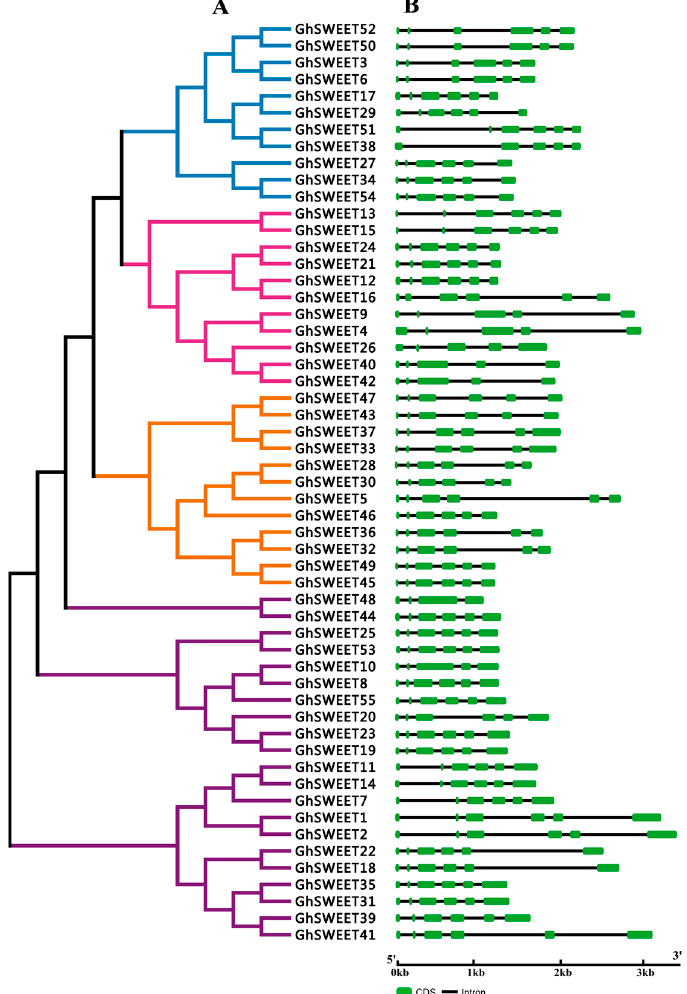
Figure 2. Phylogenetic relationships and structural features of GhSWEET genes. ( A ) Neighbor-joining phylogenetic tree of GhSWEET genes. The SWEET genes were classified into four clades, and blue, pink, purple, and orange represent Clades I, II, III, and IV, respectively. ( B ) Exon-intron organization of GhSWEET genes. Green and black correspond to exons and introns, respectively.